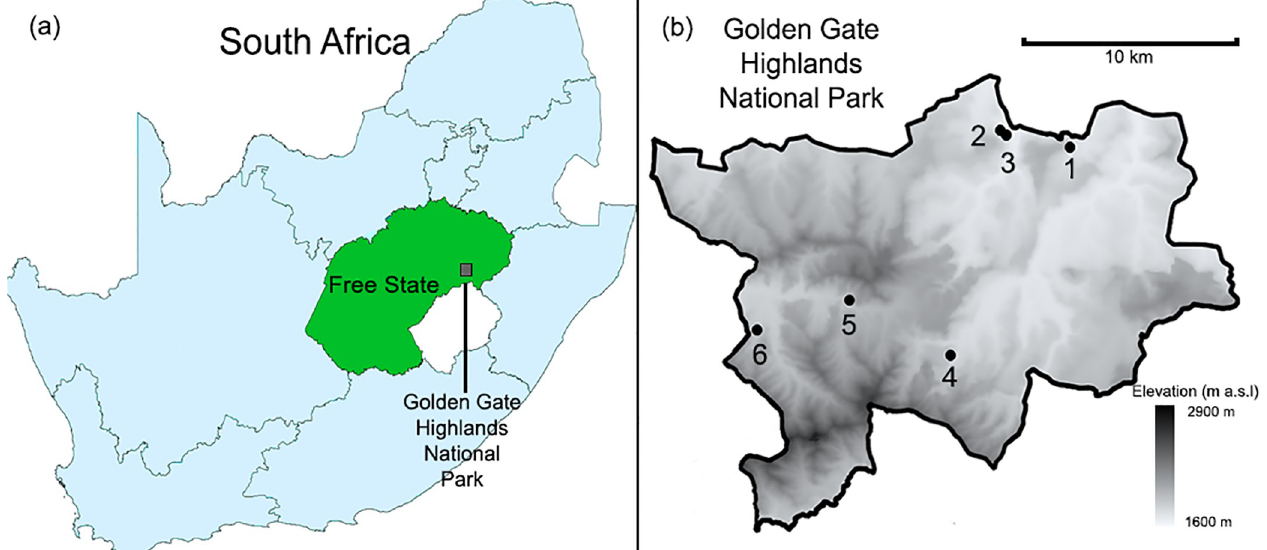
Fig 1. Location of study area. (a) Location of Golden Gate Highlands National Park in the Free State Province, South Africa. (b) Map of the six shrubland sampling localities. Elevation map created using Shuttle Radar Topography Mission (SRTM) terrain height data equal to three seconds of arc latitude and longitude and approximate resolution of 90 m. Developed using QGIS, version 2.18.15. SRTM3 topography data available from USGS Earth Resources Observatory and Science Center (http://eros.usgs.gov/#).